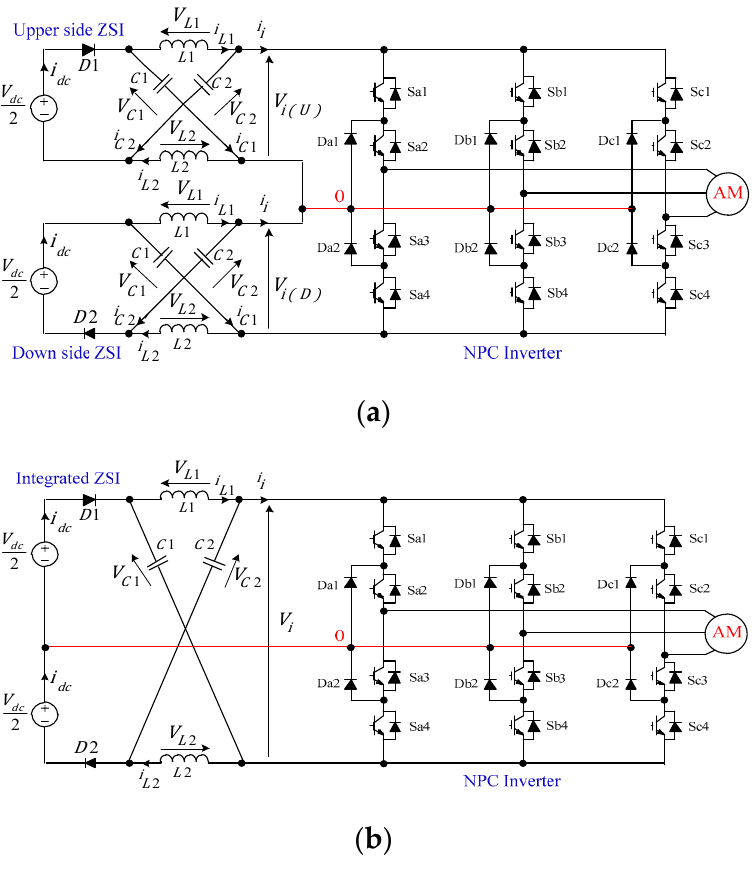
Figure 5. Impedance source multi-level network: ( a ) Two network utilization; ( b ) integrated network